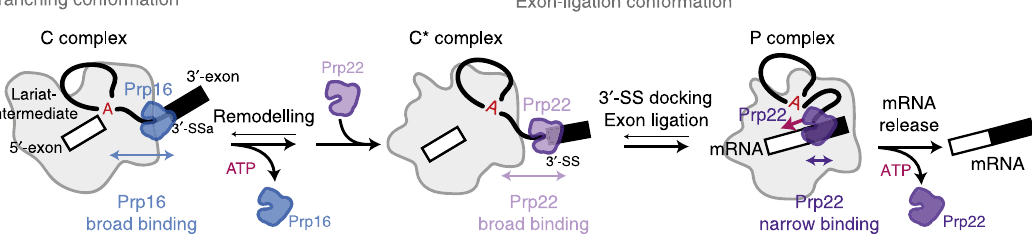
Fig. 7 Model for substrate binding by spliceosomal helicases during the catalytic stage of pre-mRNA splicing. After branching, Prp16 binds the lariat intermediate broadly downstream of the brA, though the main binding peaks are observed between the brA and the 3 ′ -SS. Prp16 dissociates during remodelling to the C* conformation, in which it is replaced by Prp22 before docking of the 3 ′ -SS. In complex C*, before exon ligation, Prp22 binds the lariat intermediate broadly on the 3 ′ -exon and the intron. Such broad binding may facilitate 3 ′ -SS docking to allow exon ligation. After exon ligation, in complex P, Prp22 engages the mRNA in a narrow binding window on the 3 ′ -exon, from which it pulls on the RNA substrate to release the mRNA and dissociates following mRNA